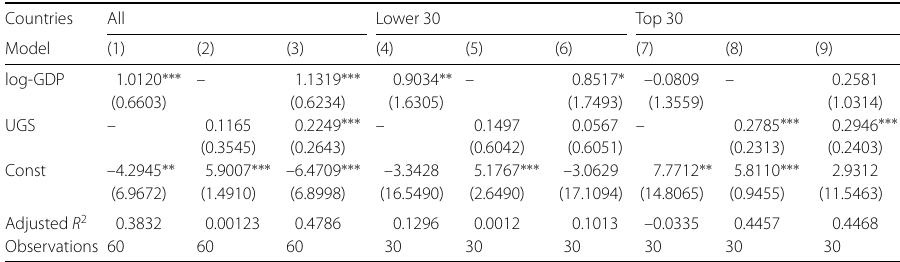
Table 1 The regression analysis for the UGS, happiness and log-GDP. The values denote the regression coefficients and the confidence intervals of each independent variable with its significance (i.e., ∗∗∗ p < 0.01; ∗∗ p < 0.05; ∗ p < 0.1). The regression model (1-3), model (4-6) and model (7-9) are examined for the data of all countries, the lower 30 countries and the top 30 countries ranked by GDP, respectively Countries All Lower 30 Top 30 Model (1)